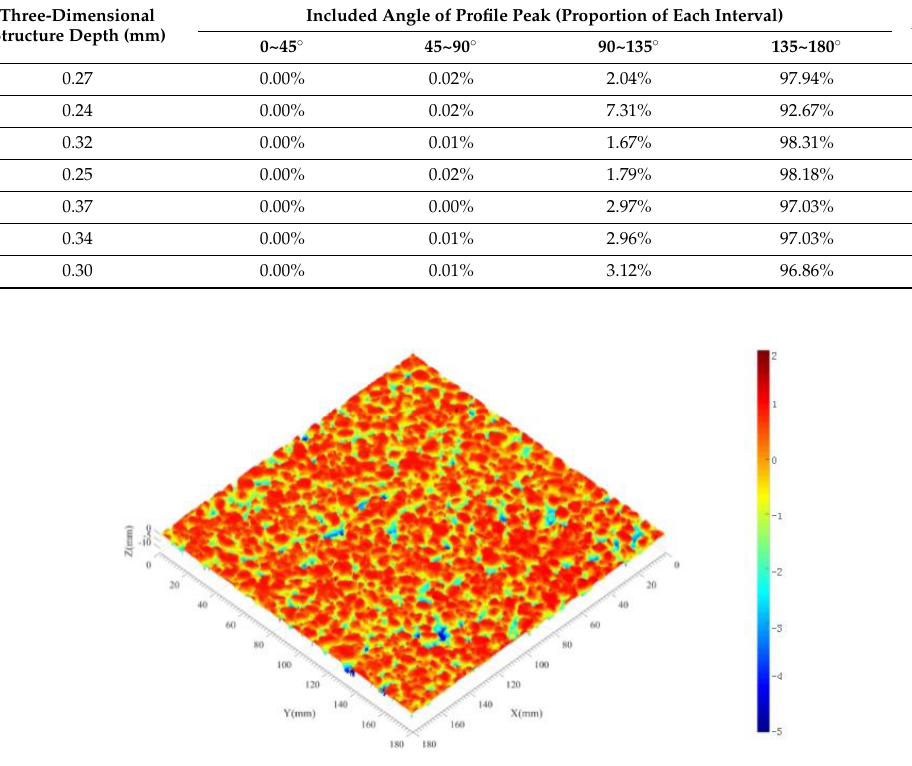
Figure 12. Laser texture image of FAC-10 detection point.